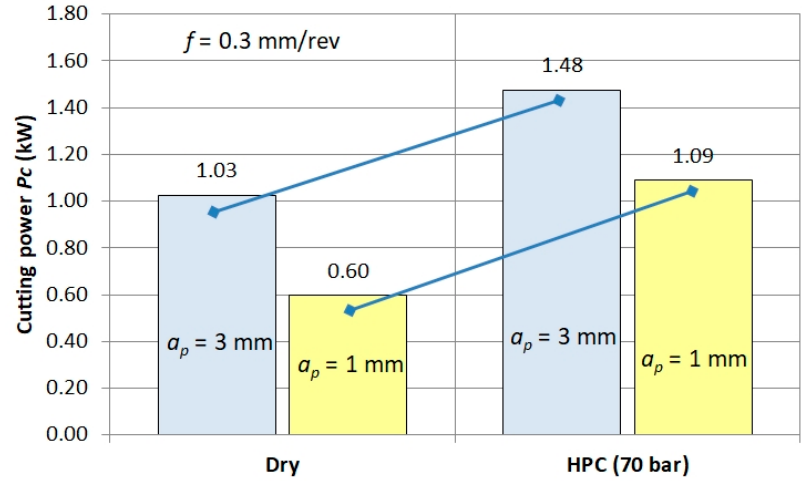
Figure 12. Example of Pc power demand for dry machining and HPC.